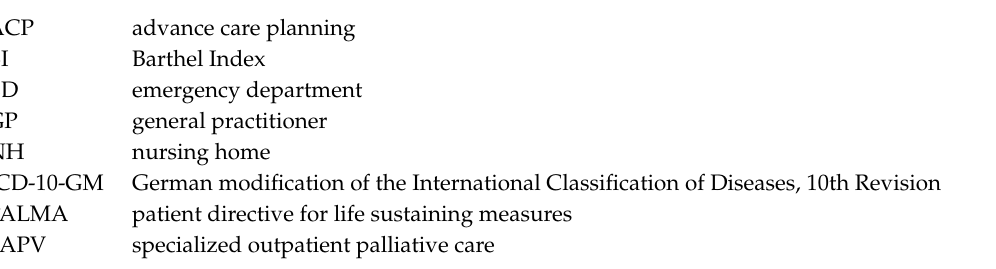
Table S1: Characteristics of planned transferred nursing home residents and the respective hospital